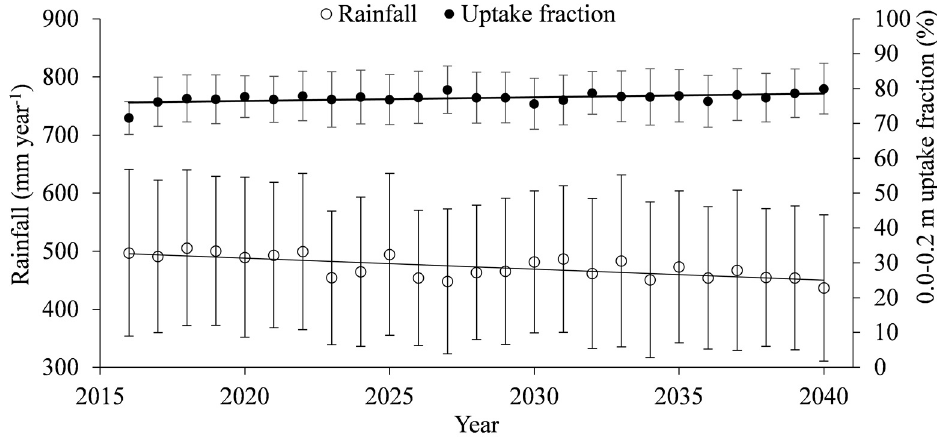
Figure 4. Annual rainfall and fraction of total transpired water taken up from the 0.0–0.2 m soil layer, together with respective standard deviations. Results obtained from stochastic simulations. Trendlines obtained by linear fitting to average values.